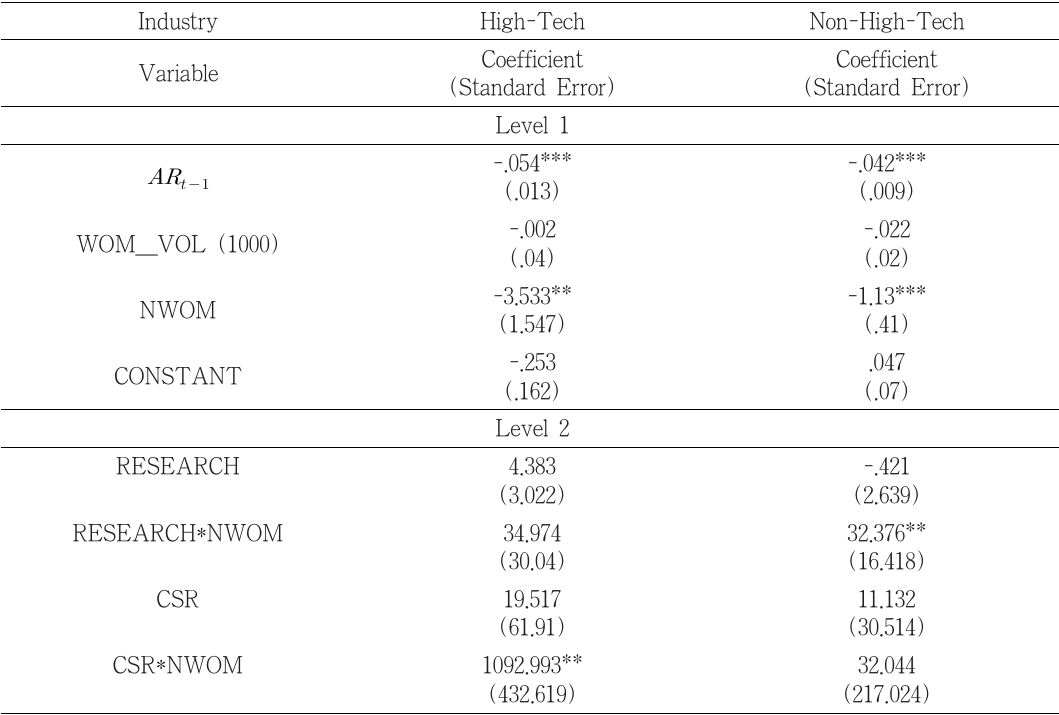
<Table 7> Parameter Estimates of the Model (High-Tech and Non-High-Tech